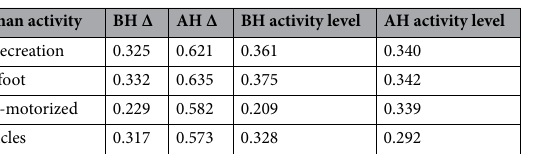
Table 3. Human activity overlap (Δ) with black bears and activity level estimates before hibernation (BH) and after hibernation